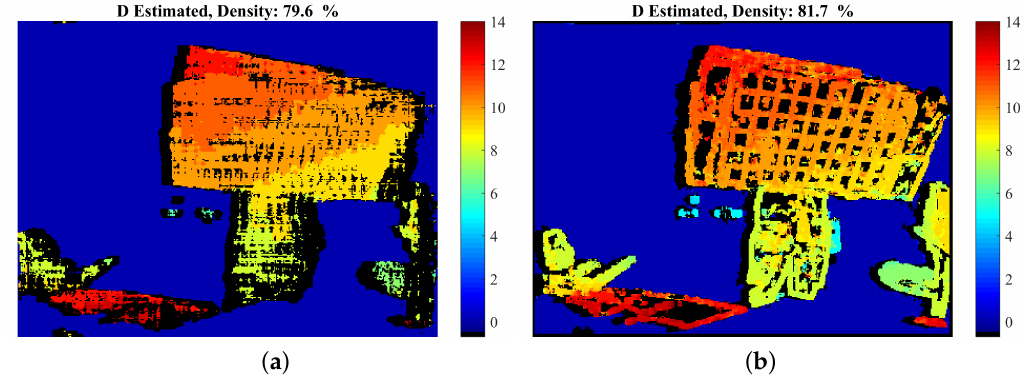
Figure 12. Natural “Dimitris-Chessboard” sequence: comparative results: Estimated disparity map of ( a ) the proposed method at density 79.6% and ( b ) GCSF [18] with density 81.7%. For the corresponding estimation error, please refer to Table 5 and the diagrams of Figure 13.